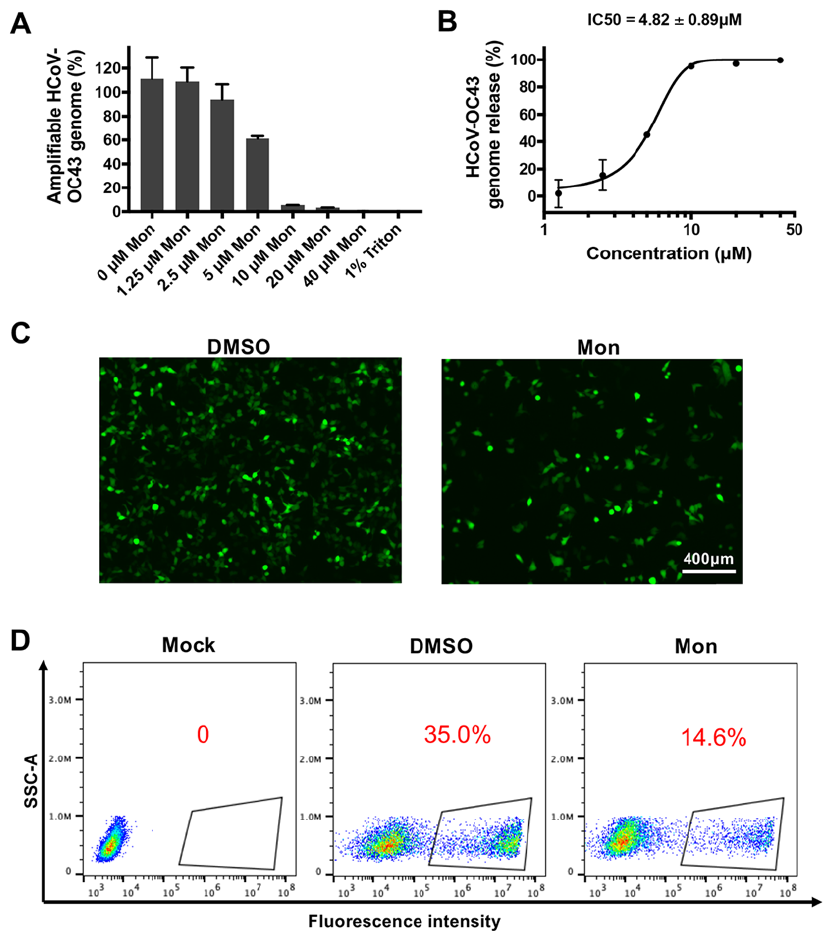
Figure 6. Montelukast (Mon) induced release of HCoV-OC43 genomic RNA by disrupting the integrity of the virions. ( A ). RNase digestion experiment was used to detect the genomic RNA unreleased by HCoV-OC43 treated with montelukast. The genomic RNA coding HCoV-OC43 nucleoprotein was detected. ( B ) The IC50 value of montelukast on release of HCoV-OC43 genomic RNA. ( C ) Montelukast affected the efficiency of transfection based on Lipoectamine 2000. The mixture of montelukast, EGFP plasmid, and Lipoectamine 2000 was incubated for 40 min at room temperature, and then added to the HEK-293T cell monolayer. Twenty-four hours after transfection, fluorescence microscopy and flow cytometry analysis detected the efficiency of transfection ( D ), scale bar: 400 µ m; red numbers: the percentage of cells expressing EGFP. Data are presented as means ± SD.